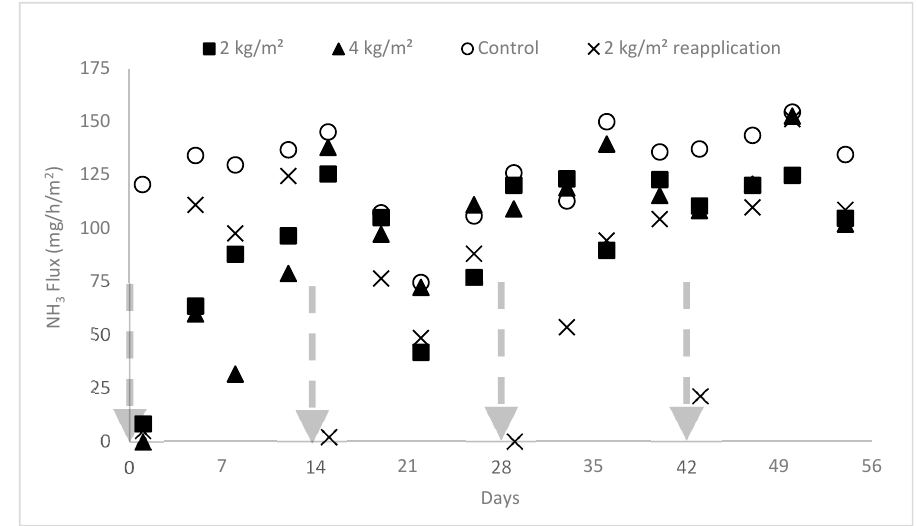
Figure 1. Mitigation of NH 3 emissions from swine manure treated with biochar—effects of one-time dose (2 and 4 kg/m 2 ) and 2 kg/m 2 bi-weekly reapplication. Vertical arrows represent the application or reapplication of biochar and manure to storage simulators. Each data point represents the mean of ( n = 3) measurements. Detailed statistical analysis is provided in Table S1.